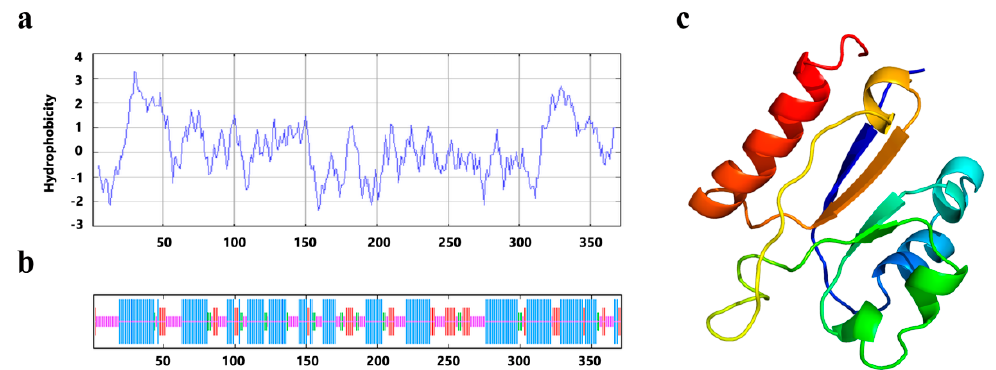
Figure 2. Predicted structure of PrLPAAT4. ( a ) hydrophobicity plot predicted by the Kyte–Doolittle method of a sliding window average over nine neighboring residues; ( b ) the secondary structure of PrLPAAT4. Blue, red, green, and pink lines show the predicted α -helices, extended strands, β -turns, and random coils, respectively; ( c ) tertiary structure of the partial PrLPAAT4 protein. The helical structures show the predicted α -helices, and the arrows indicate the β -sheets.